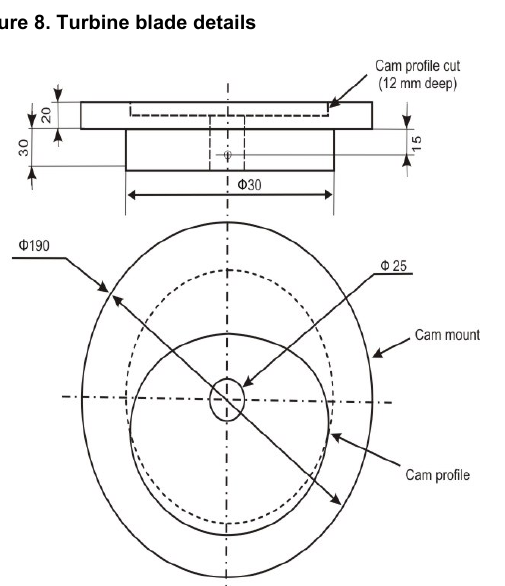
Figure 9. Cam profile and cam